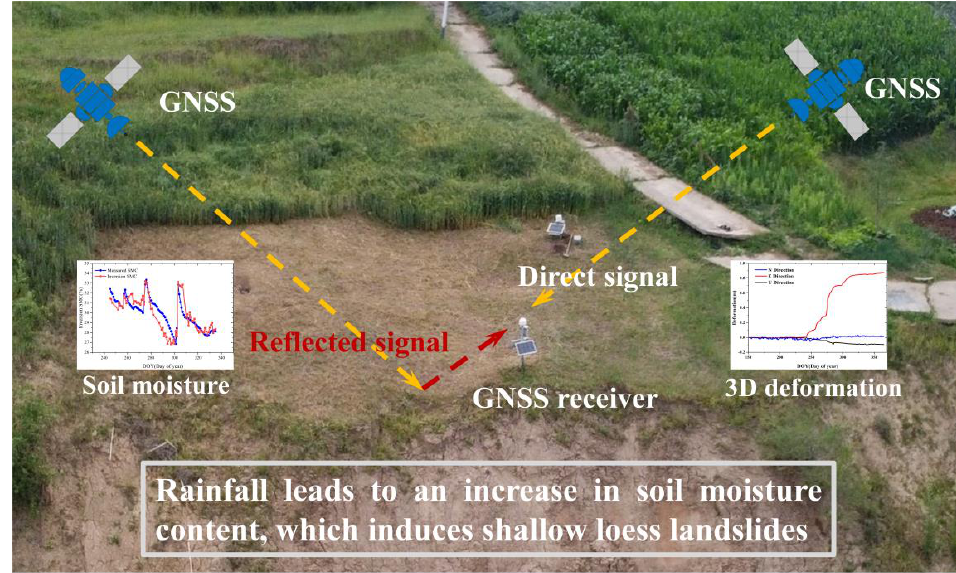
Figure 1. Application of Global Navigation Satellite System (GNSS) in landslide monitoring.